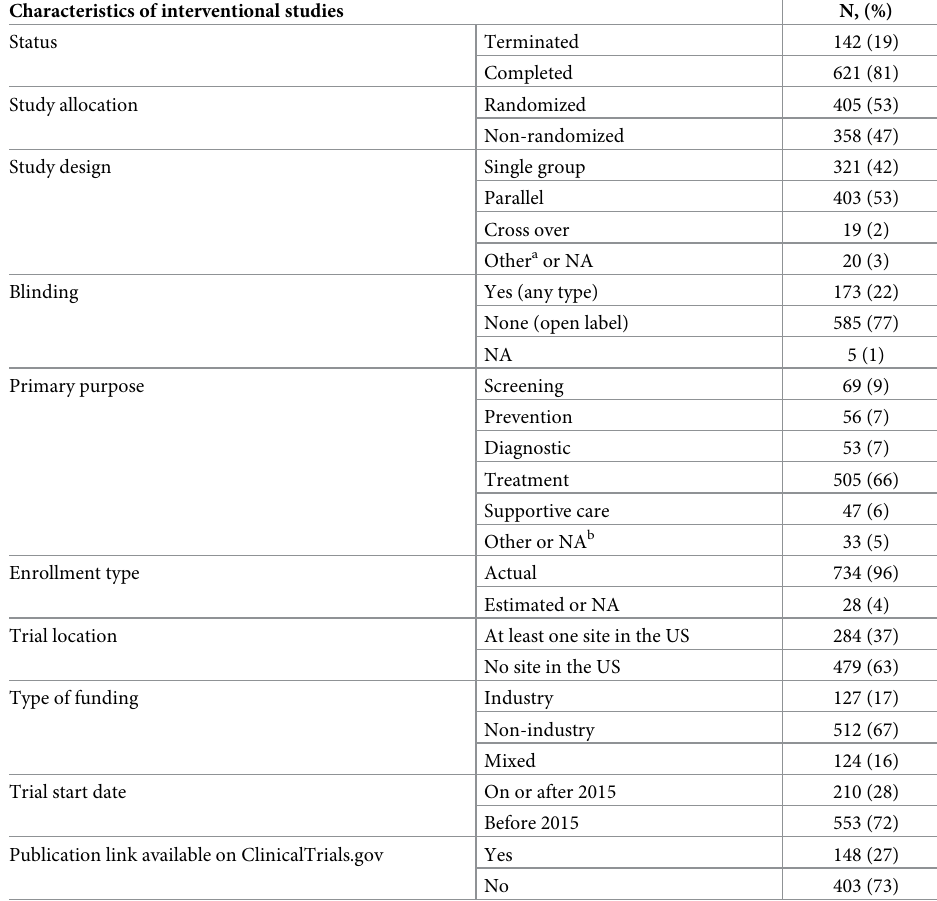
Table 1. General characteristics of the eligible interventional studies (N = 763). Characteristics of interventional